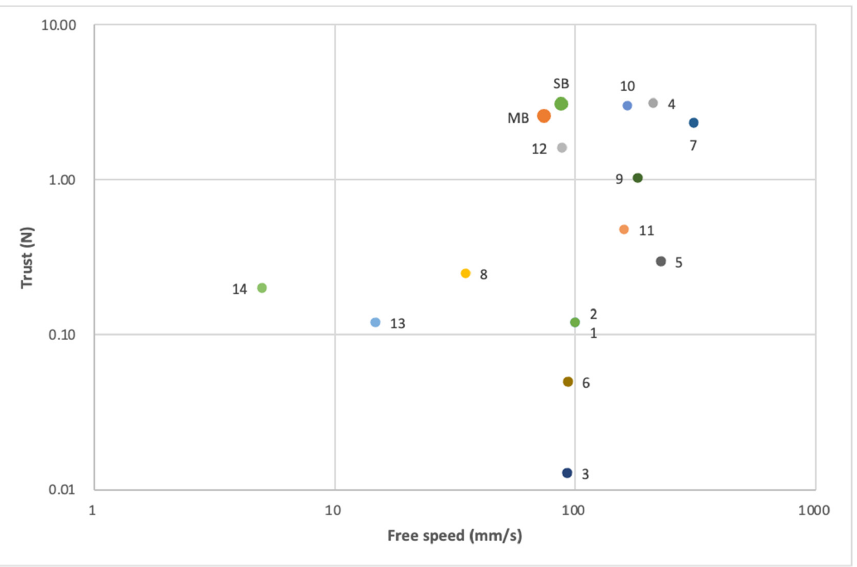
Figure 20. Comparison of the USMs: the relationship between the free speed and the thrust force.